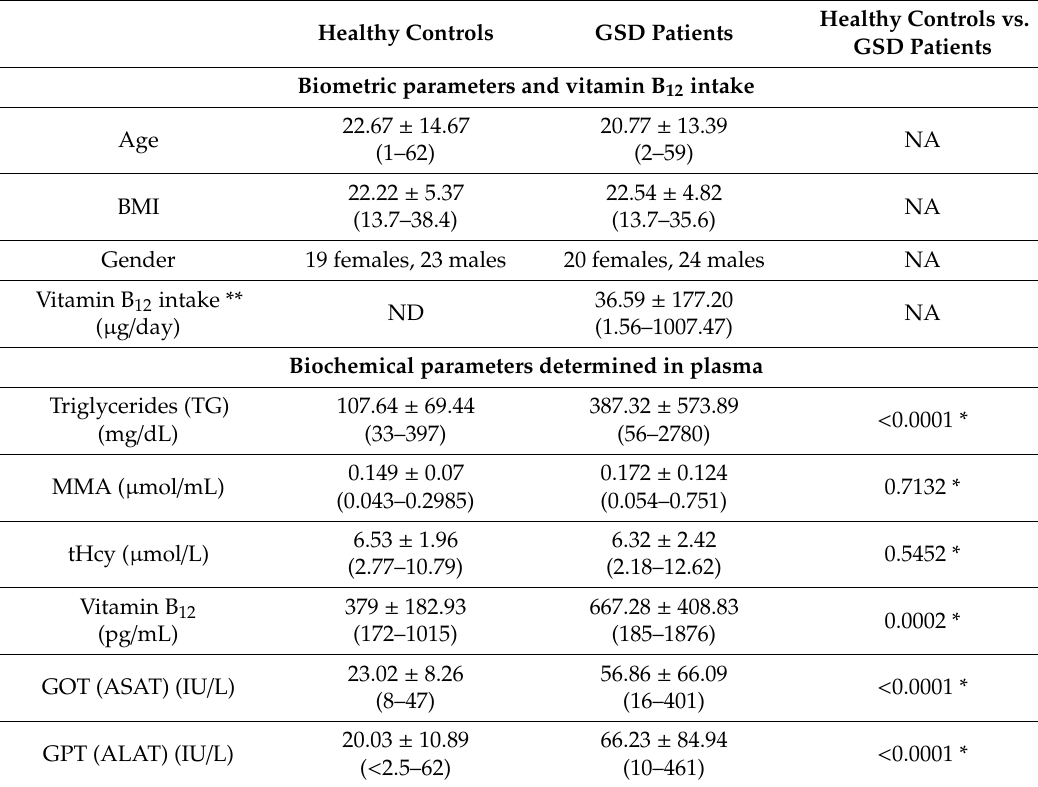
Healthy Controls